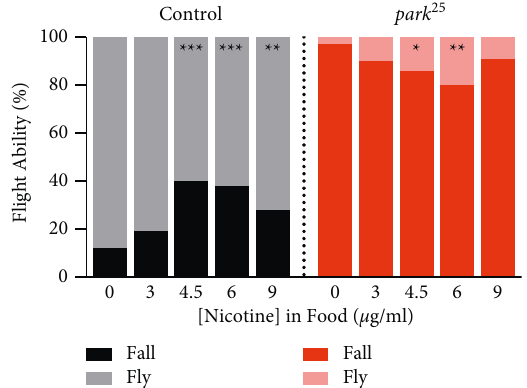
Figure 3: Nicotine increases flight ability in homozygous park 25 flies. Homozygous park 25 and control flies were tested for their ability to fly with various concentrations of nicotine from day 0. Results from a post hoc Marascuilo procedure of a Chi-square analysis with a Bonferroni correction are shown. Asterisks inside the bars compare between that group and the 0 μ g/mL group within that fly genotype. ∗∗∗ � P < 0 . 001, ∗∗ � P < 0 . 01 ∗ � P < 0 . 05. The results of each data point are from at least four separate experi- ments with an n ≥ 50